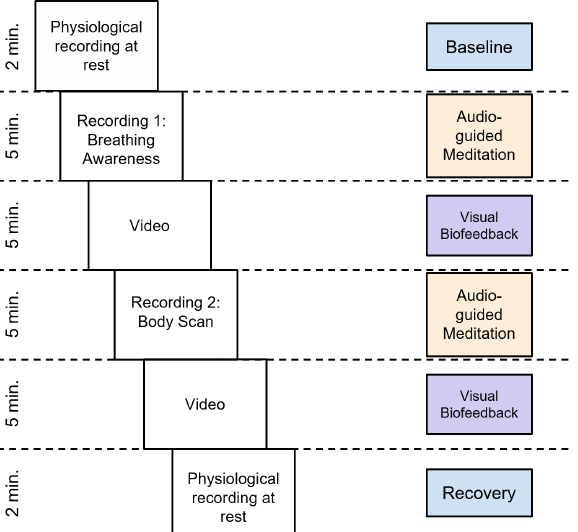
Figure 5. Chronological representation of the biofeedback-assisted mindfulness training